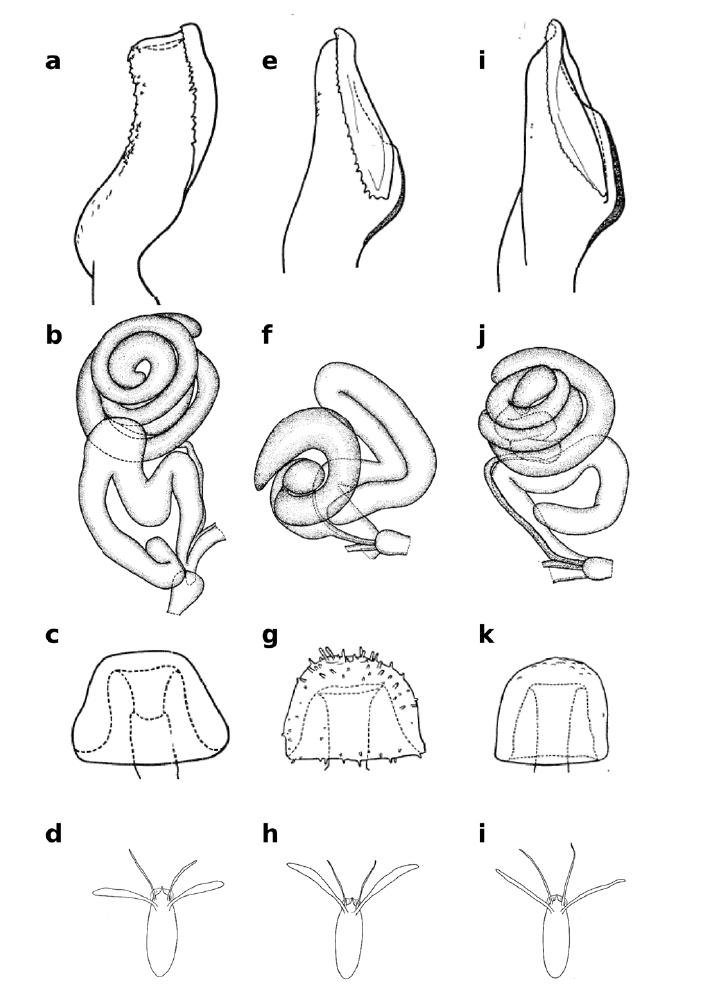
Distiphallus, testis and accessory gland, spermatheca and egg of Zaprionus mascariensis Tsacas & David a–d, Zaprionus sepsoides Duda, 1939 e–h, and Zaprionus tuberculatus Malloch, 1932 i–l [From Tsacas et al. 1977; courtesy of M. T. Chassagnard].